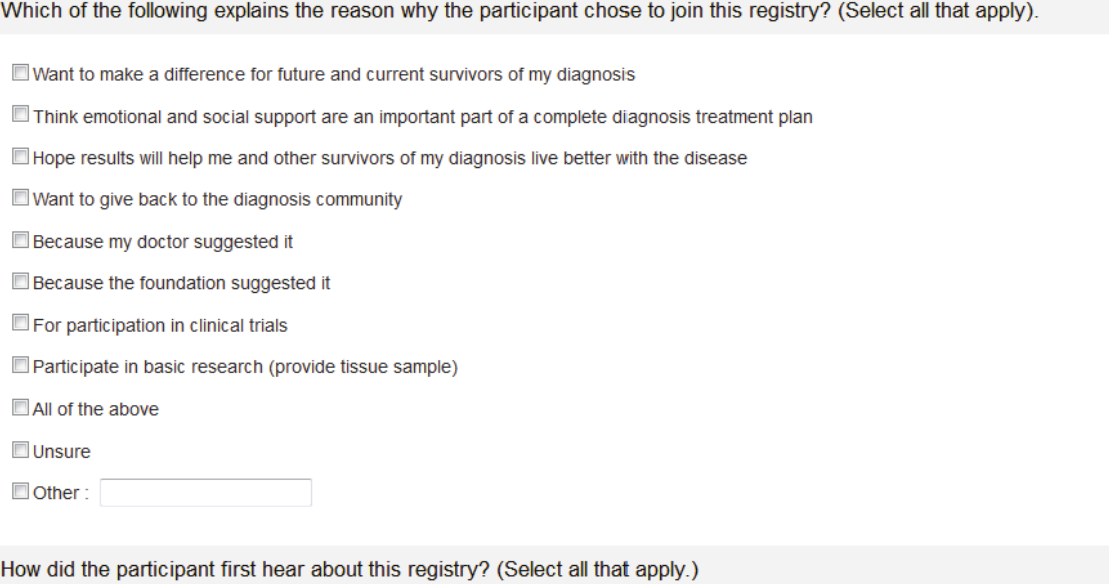
Supplemental Figure 10.